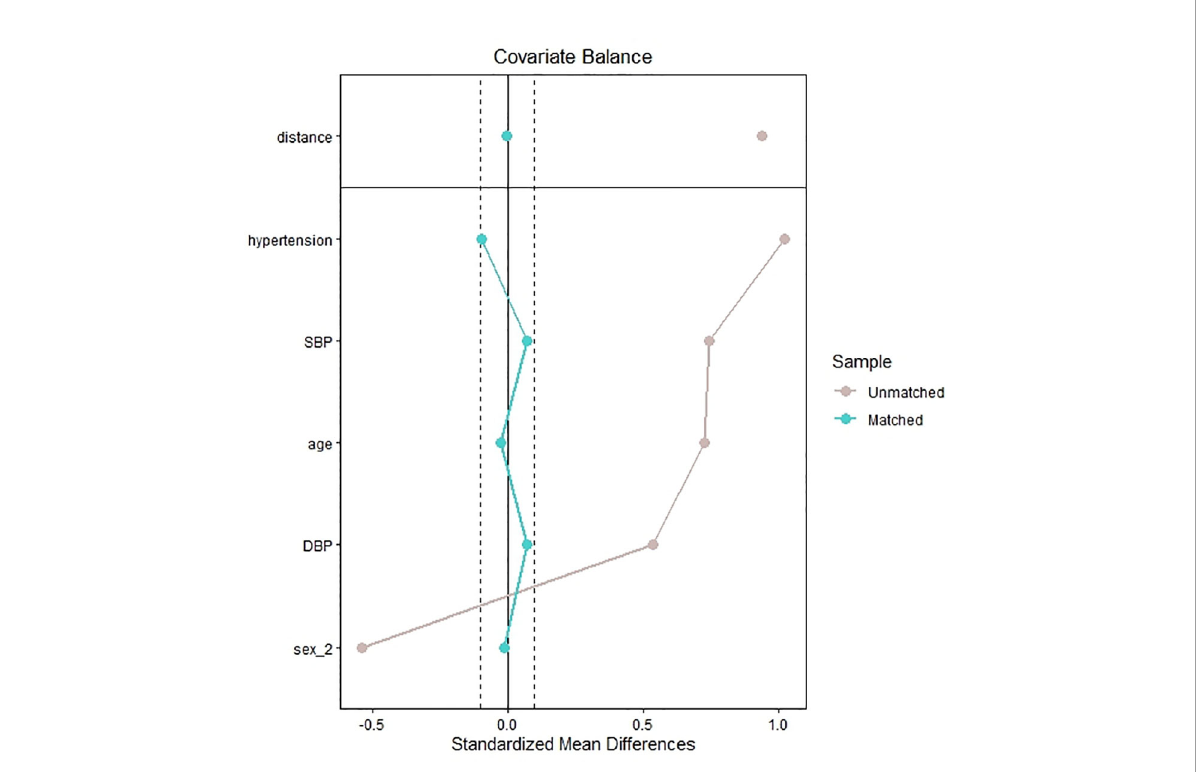
FIGURE 1 Standardized mean difference of the matching covariates between the case group and control group before and after propensity score